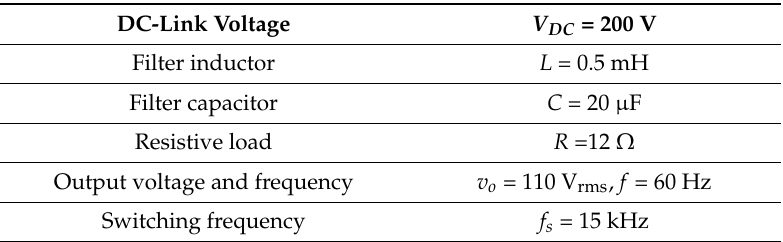
Table 1. System parameters. DC—direct